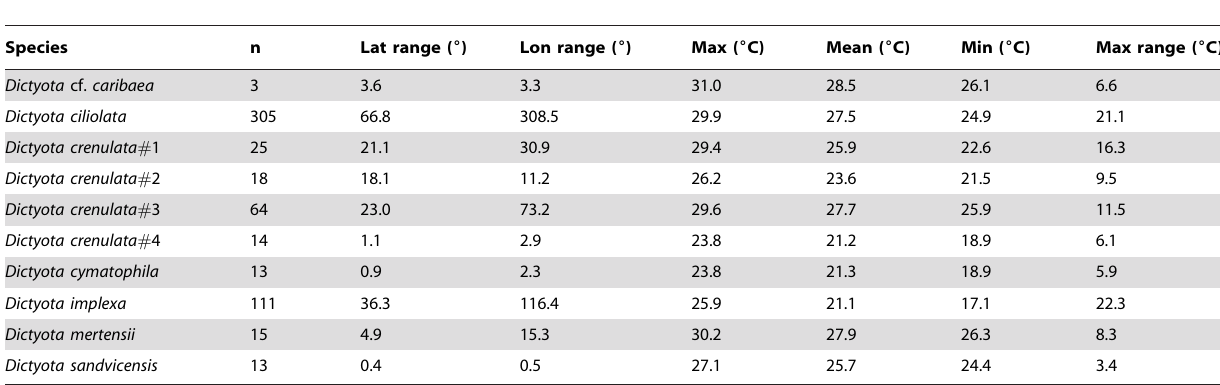
n=number of records. Lat range=latitudinal range. Lon range=longitudinal range. Max=mean of the maximum SST.